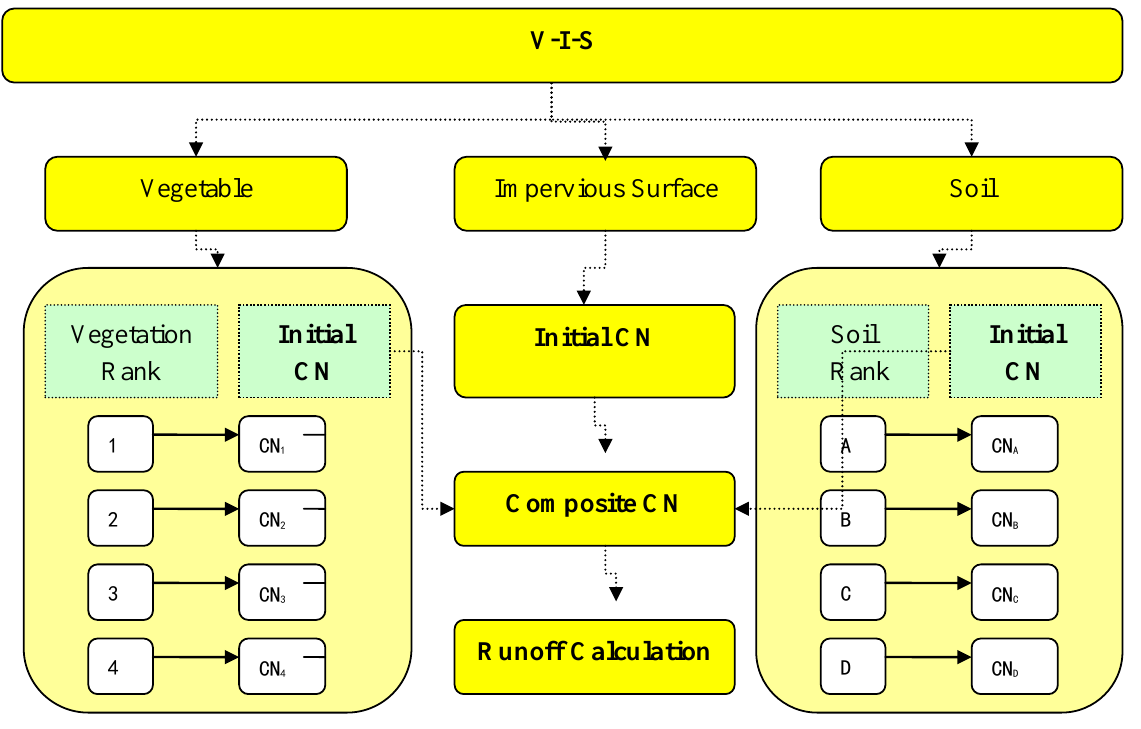
Figure 2. Procedure for computing composite